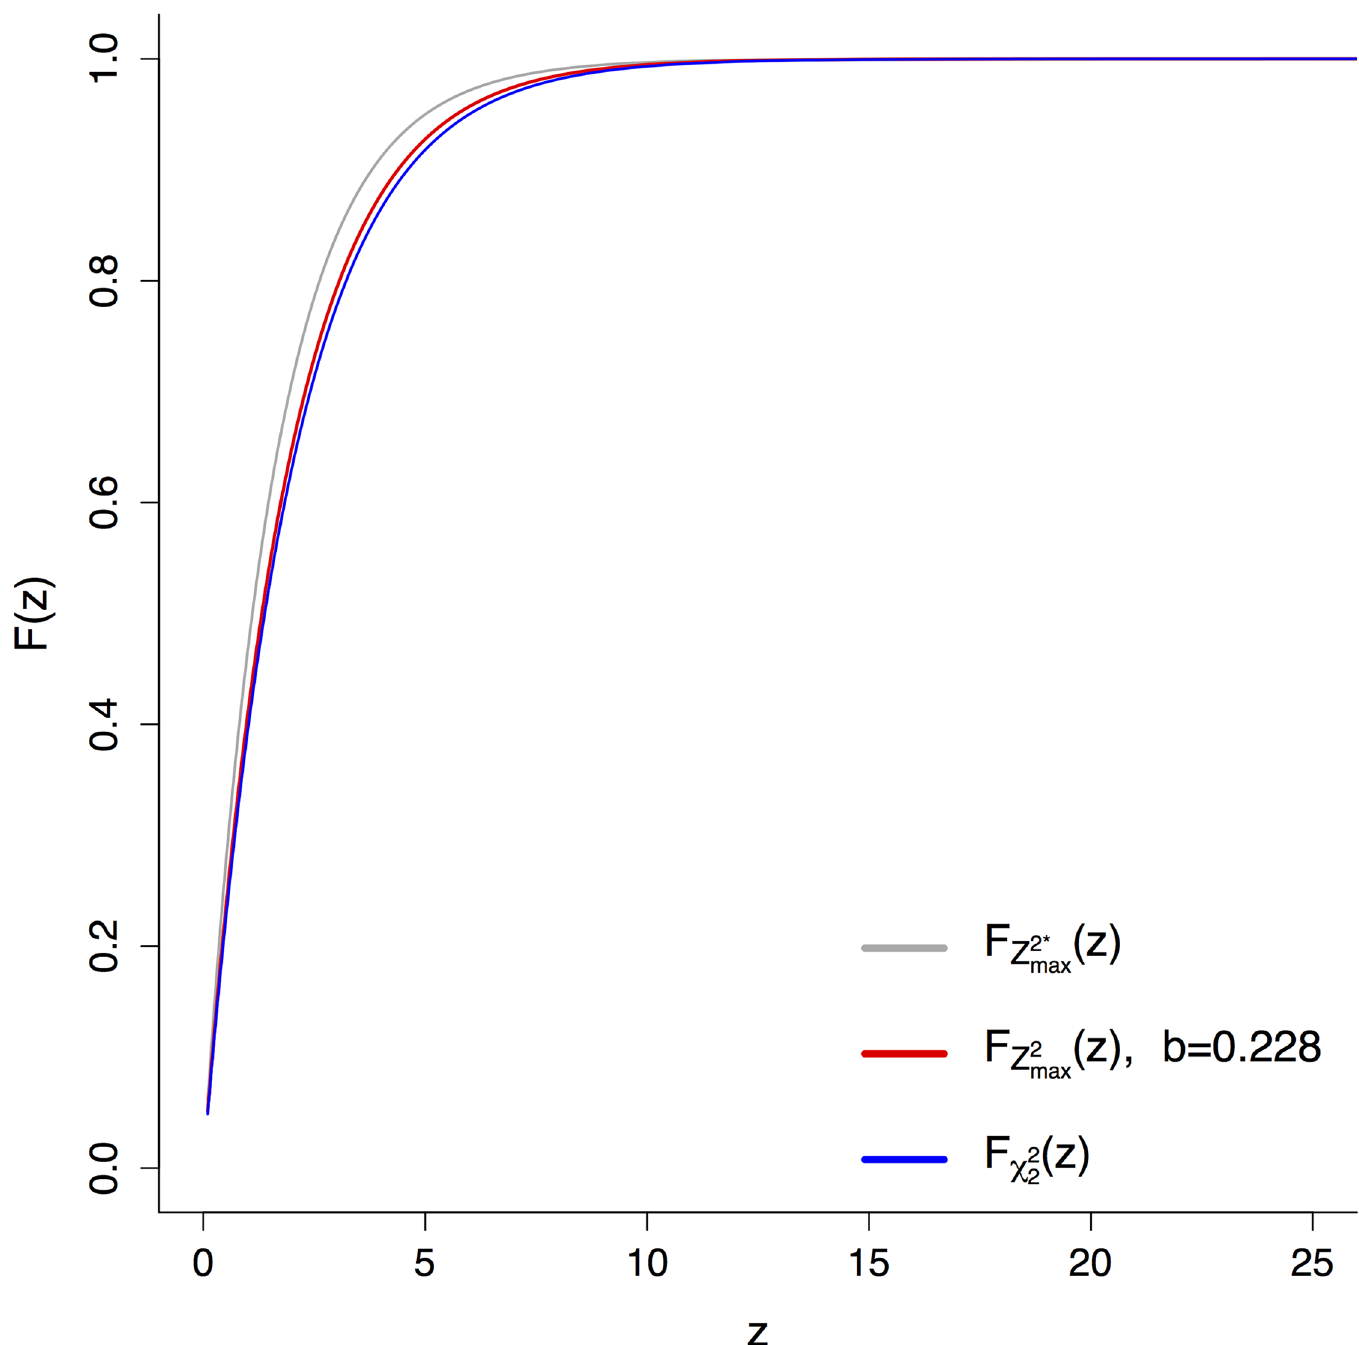
Fig 2. Comparison of F Z 2 (cid:5)